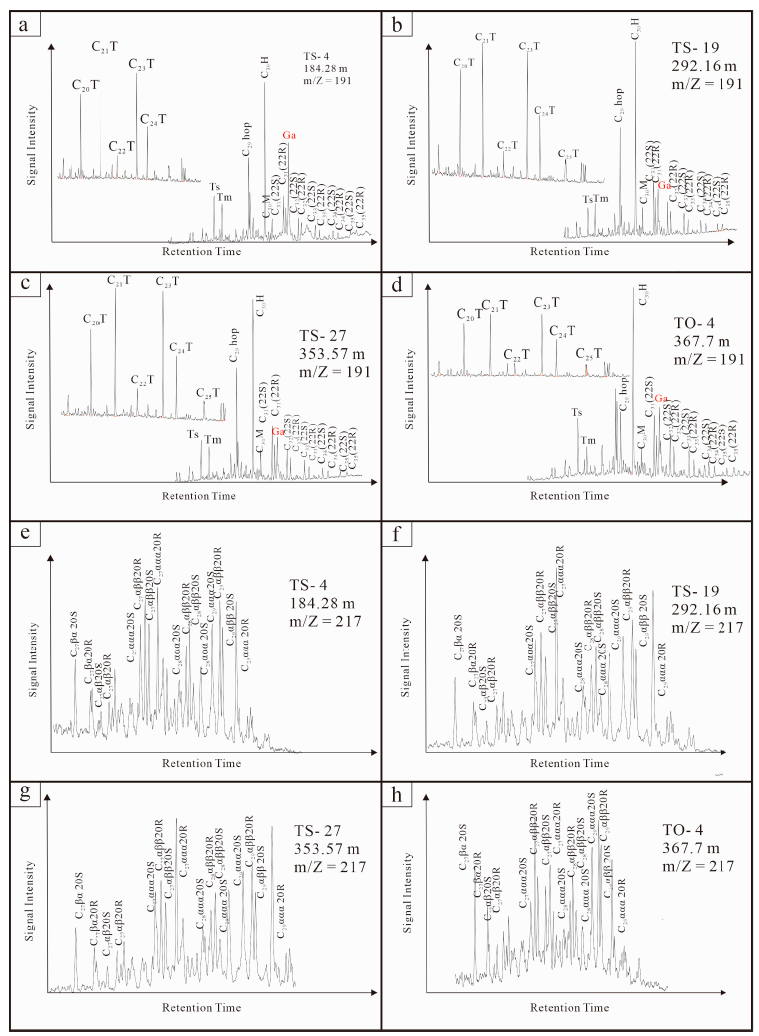
Figure 6. Gas chromatograms–mass spectrometry (TIC) ( a – d ) and m/z 85 mass chromatograms ( e – h ) of saturated hydrocarbons of the Hengtongshan Formation samples in the Tonghua Basin.